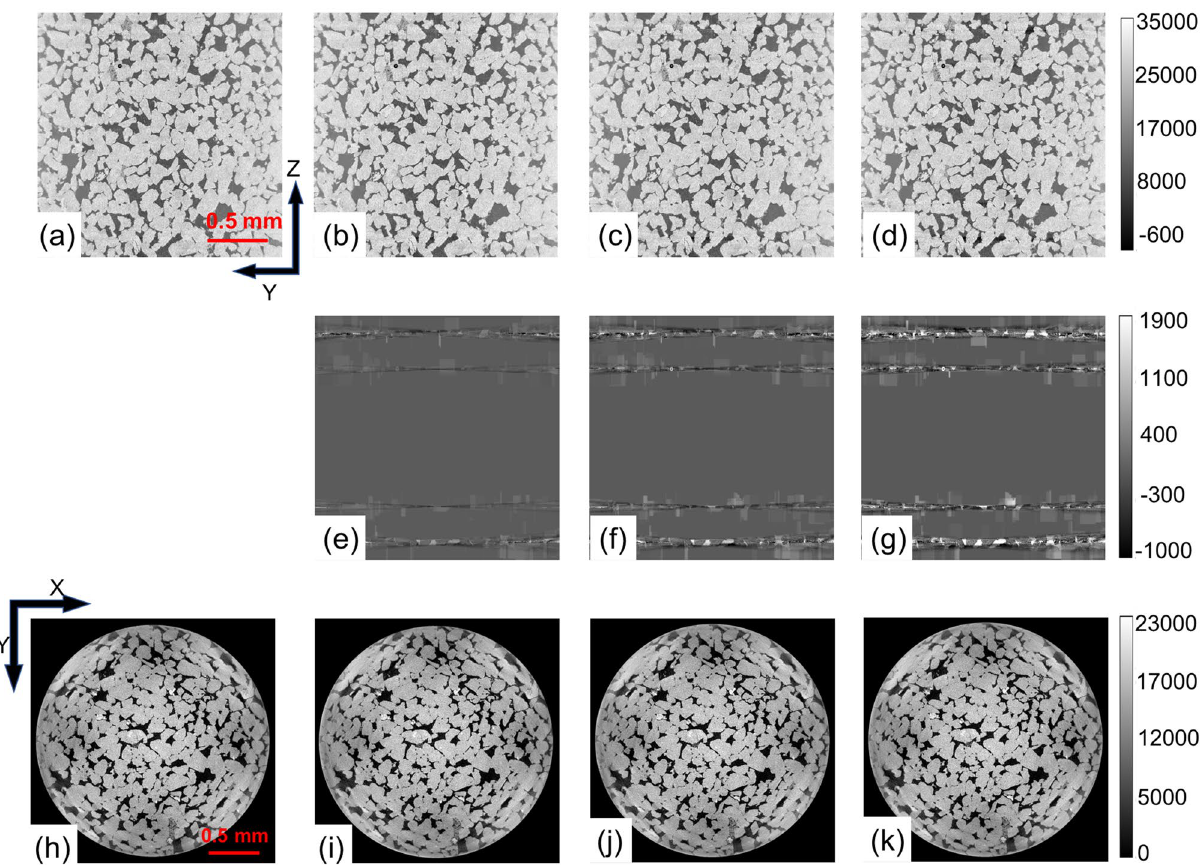
Figure 4. Reconstruction results obtained by varying the overlap size in the multi-GPU implementation. 1536 1536 volume using overlap Reconstruction results corresponding to the Y–Z plane at X = 0 for 1536 × × size as ( a ) 48 ( b ) 39 ( c ) 32 ( d ) 24. The difference image (on the Y–Z plane at X = 0) between ( e ) overlap size as 48 and 39 ( f ) overlap size as 48 and 32 ( g ) overlap size as 48 and 24. Reconstruction results corresponding to the 1536 1536 volume using overlap size as ( h ) 48 ( i ) 39 ( j ) 32 ( k ) X–Y plane at Z = 0 for 1536 × ×